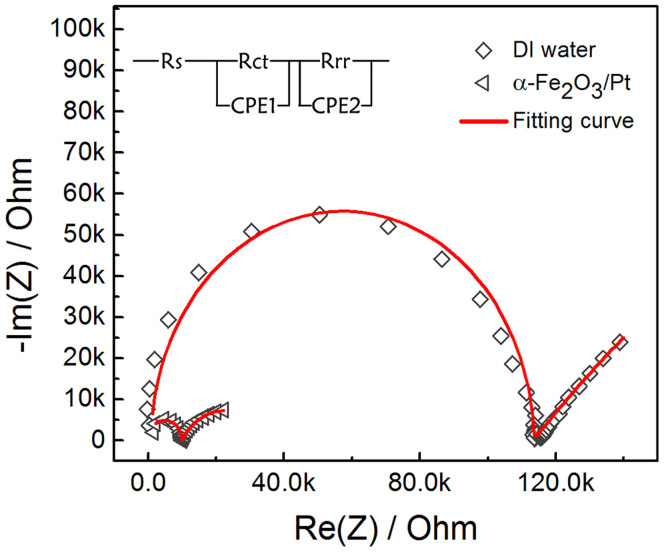
Nyquist plots of TiO2/In2S3/AgInS2 in DI water and DI water containing 0.1 mg/mL α−Fe2O3/Pt measured at open-circuit conditions under simulated solar-light illumination.